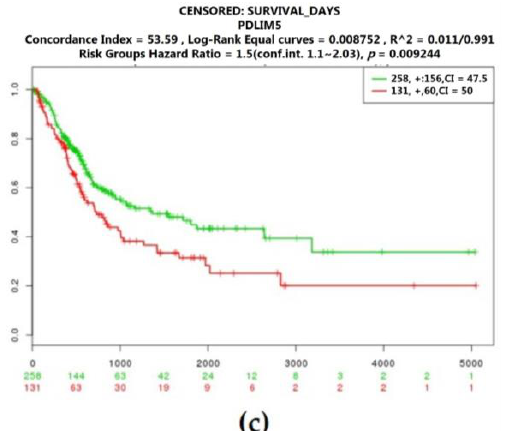
Figure 8. Overall survival of the co-expression of hub genes of bladder cancer with grade 3 carcinoma based on Kaplan–Meier plotter. The horizontal axis represents the time to event. The patients were stratified into the high-level group and low-level group and labeled with color. The red line indicates the samples with high risk, and the green line shows the samples with low risk. p < 0.05 is considered a statistically significant difference in mortality between the high-level group and low-level group. ( a ) Gelsolin (GSN); ( b ) HtrA serine peptidase 1 (HTRA1); ( c ) PDZ and LIM domain 5 (PDLIM5).